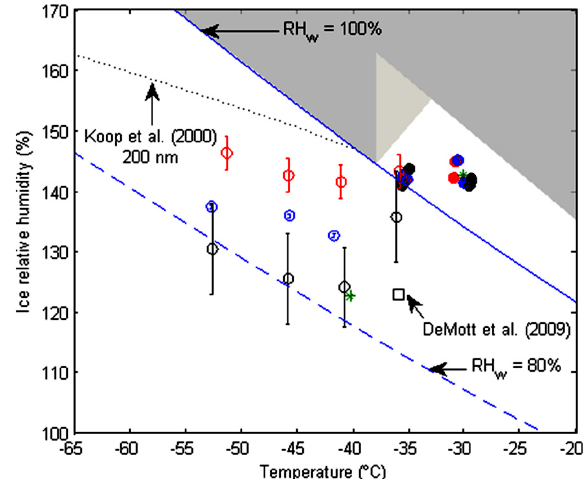
Fig. 2. Conditions for ice nucleation on 5% of CID particles as a function of temperature for sizes: 200nm (red), 300nm (blue), 400nm (black). Open symbols represent data collected with the laboratory unit and filled symbols represent data collected with the aircraft unit. Green stars represent conditions for ice nucleation on 1% of polydisperse CID particles during ICIS. The dark gray shad- ing indicates the region where droplets are known to be counted by the OPC in the CFDC systems. The light gray shading indicates the transition where the state of the particle counted by the OPC is ambiguous. Water saturation, RH w = 80% and the conditions for which 200nm (NH 4 ) 2 SO 4 particles nucleate ice according to Koop et al. (2000) are indicated in the figure for